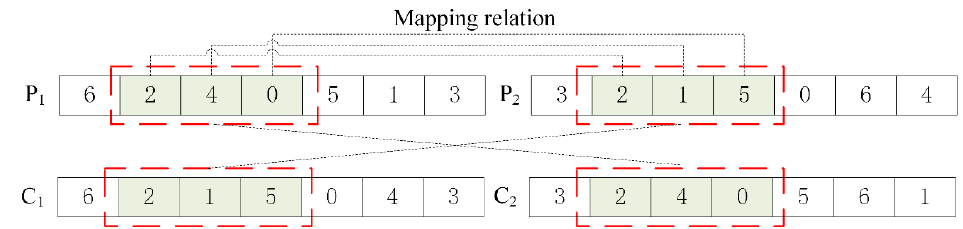
Fig. 3. Example of the crossover operation